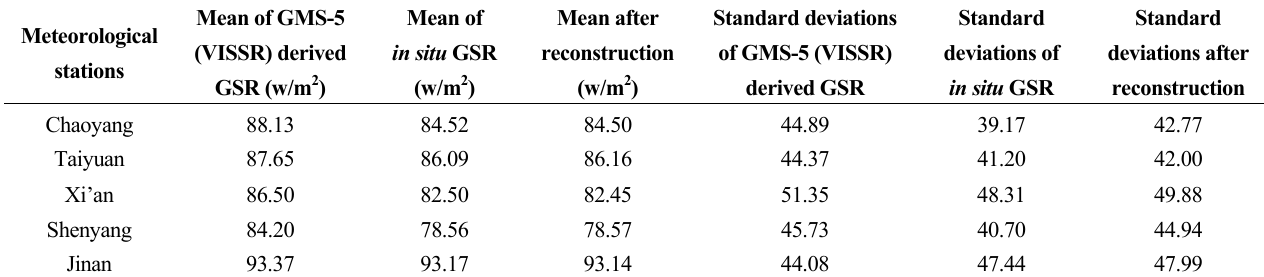
Table 2. Comparison of GMS-5(VISSR) derived GSR, in situ GSR and the reconstructed GSR.